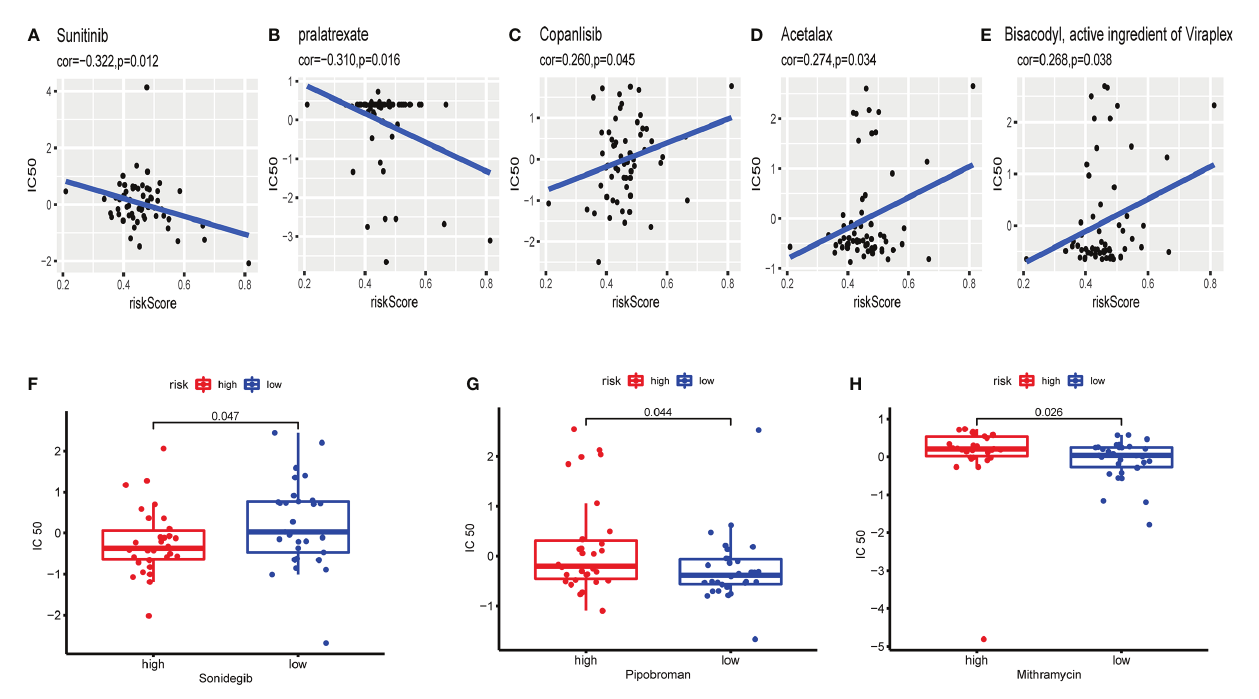
FIGURE 13 | The exosome-related risk model as a potential predictor for chemosensitivity. (A – E) The respective IC 50 value of chosen compounds in relation to the risk score, as shown by Pearson ’ s correlation analysis (sunitinib, pralatrexate, copanlisib, acetalax, and bisacodyl) appeared to associate signi fi cantly with the exosome-related risk model (|Pearson ’ s correlation|>0.25 and p < 0.05). (F) Those with high-risk scores were found to possess lower IC 50 scores for FDA-approved chemotherapeutics such as sonidegib ( p < 0.05). (G , H) Those with low-risk scores were indicated to possess lower IC 50 scores for medications including pipobroman and mithramycin ( p < 0.05). The p -values were calculated using the Wilcoxon ’ s